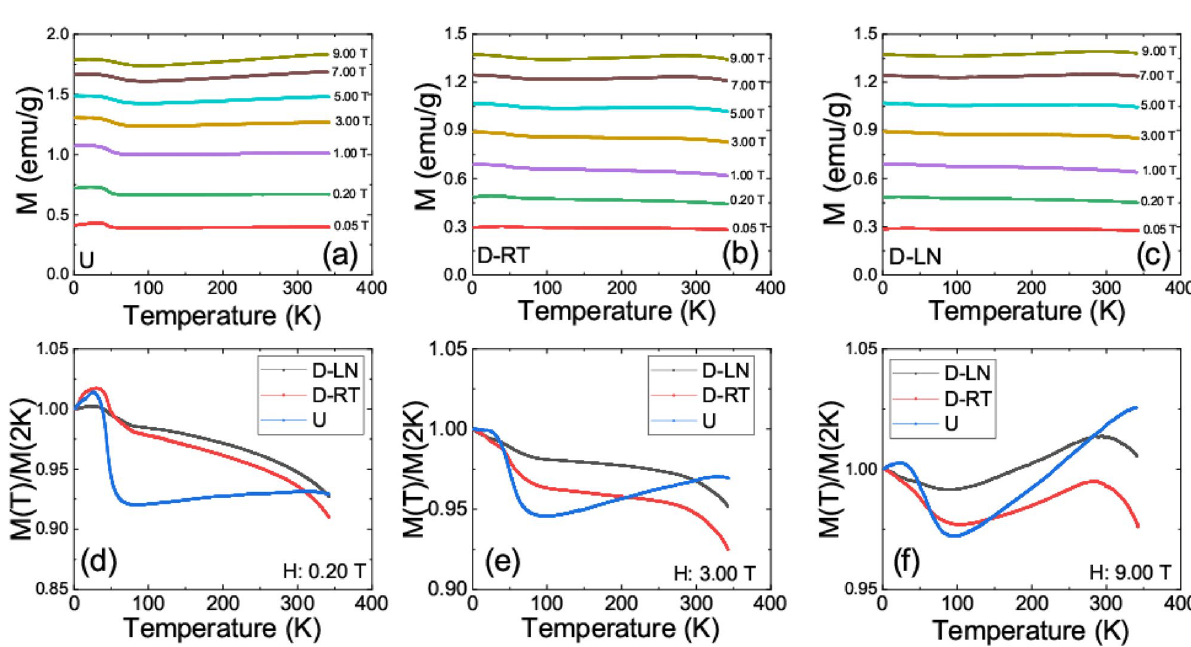
Figure 5. Temperature dependence of the zero field cooled magnetization in indicated fields for ( a ) undeformed FeMnCoCr, ( b ) Room temperature deformed FeMnCoCr, ( c ) Liquid Nitrogen deformed FeMnCoCr. Temperature dependence of the zero field cooled magnetization normalized to its value at 2 K for undeformed and deformed samples in ( c ) 0.20 T ( d ) 3.00 T ( e ) 9.00